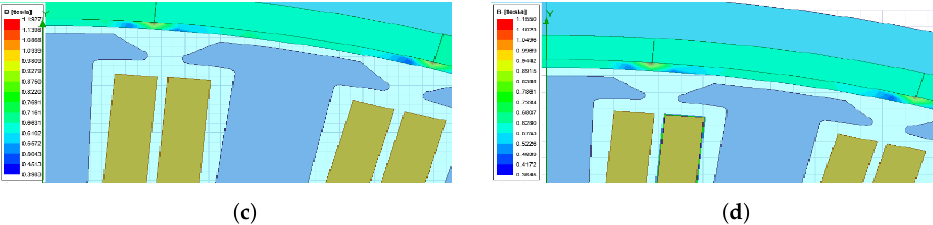
Figure 8. Magnetic flux density for air gap lengths of ( a ) 0.5 mm, ( b ) 1mm, ( c ) 1.5 mm, and ( d ) 2 mm.